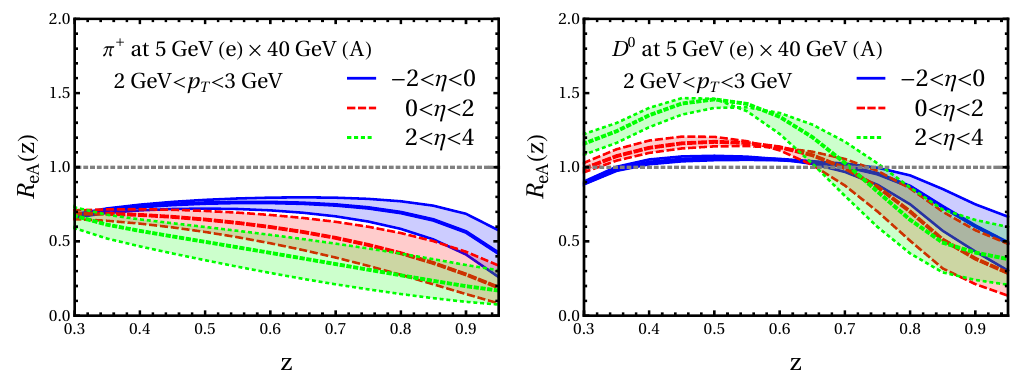
Figure 1: Left: in-medium corrections for π + production as a function of z at the EIC in three rapidity regions. Blue bands (solid lines), red bands (dashed lines), and green bands (dotted lines) correspond to -2 < η < 0, 0 < η < 2 and 2 < η < 4, respectively. Right: the same in-medium corrections, but for D 0 at the EIC in the same rapidity